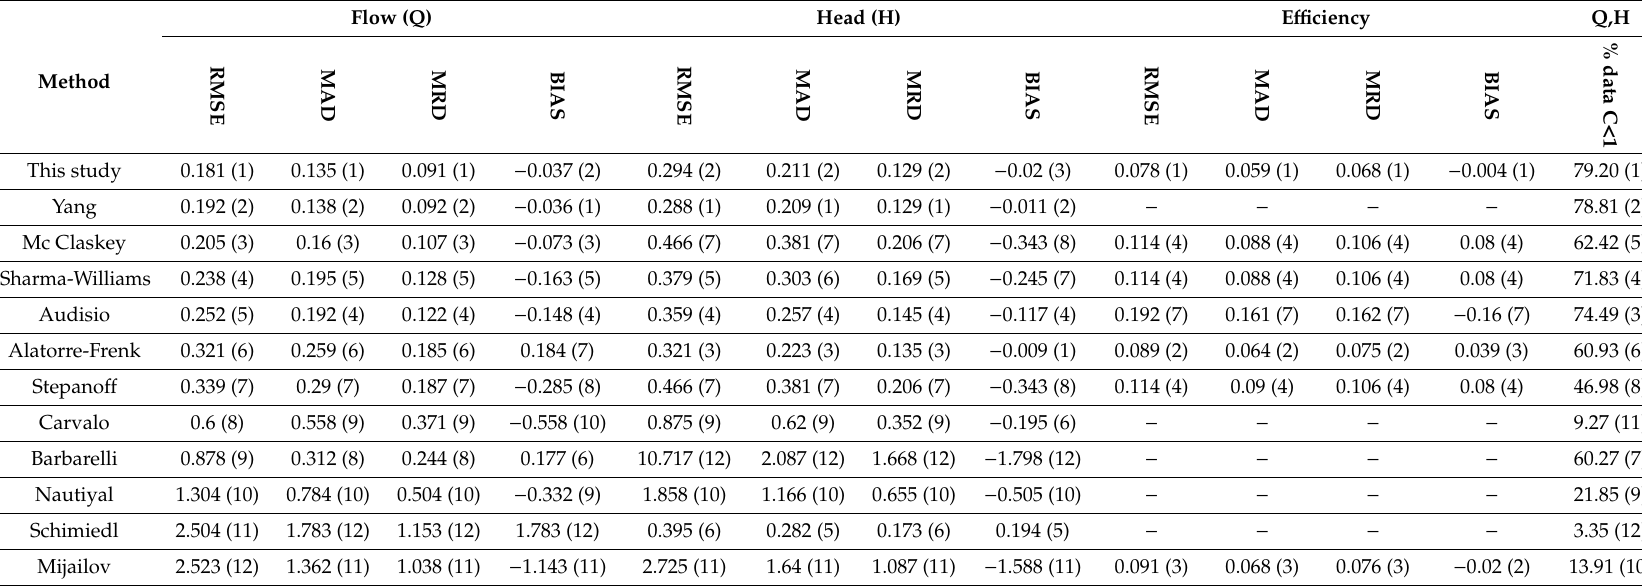
(x) indicates the classified order of the method considering the rest of the methods. Table 5. Error indexes depending on applied method to predict BEP in pump mode. MAD: mean absolute deviation, MRD: mean relative deviation, BIAS: bias and RMSE: root mean square error.